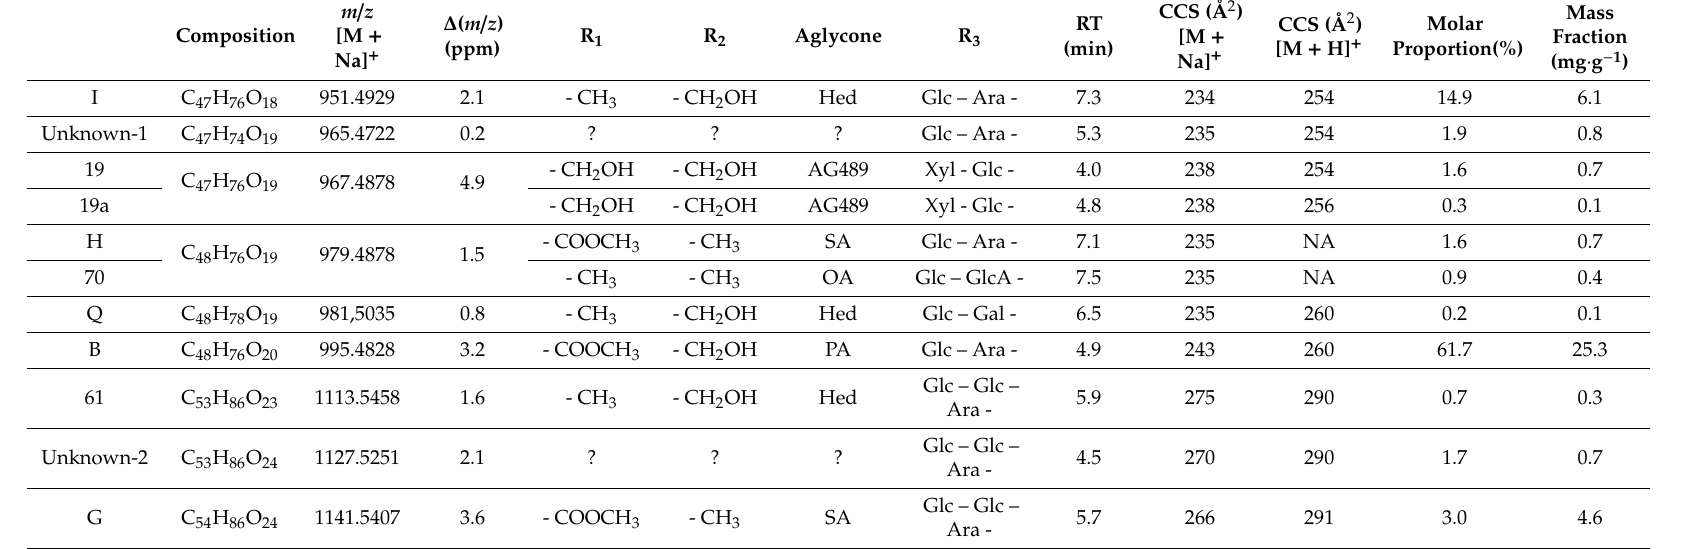
Table 1. Chenopodium quinoa natural extract (see Figure 2 for the general saponin structure): identification by MS-based methods of the saponin content. Hed, SA, OA and PA stand respectively for hederagin, serjanic acid, oleanic acid, and phytolaccagenic acid. AG489 corresponds to the aglycone #489 as defined in [6] and presented in Figure 3. RT stands for Retention Time in LC-MS experiments. CCS correspond to collision cross sections determined using traveling wave (TW) ion mobility with Nitrogen as the bu ff er gas and converted in CCS against Helium using a calibration procedure [31], namely TW CCS N2 → He using the newly introduced nomenclature [33]. The Molar Proportion (% in the quinoa husk extract) and the mass fraction (mg · g − 1 of the quinoa husk powder) of each saponin is estimated